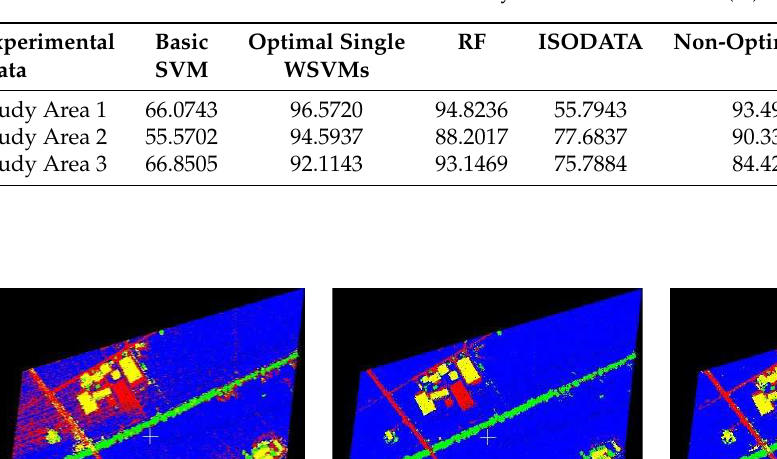
Table 4. Classification accuracy of different methods (%).